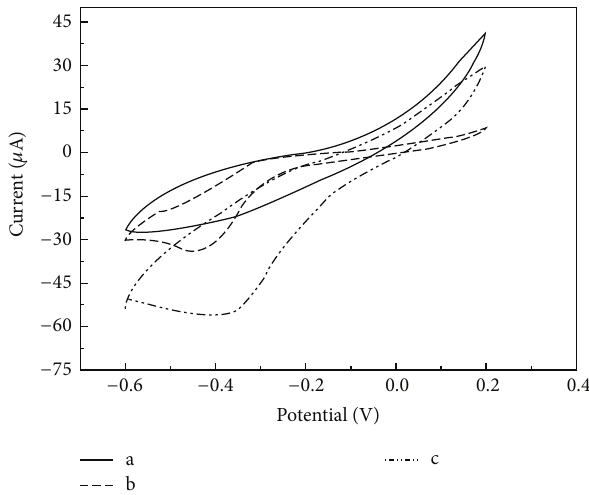
Figure 2: Cyclic voltammograms of MnO 2 for ORR at scan rate of 100 mV/s in 0.l M KOH. (a) Electrolyte bubbled with N 2 ; (b) NSM; (c) HSM. (b)-(c) Electrolyte bubbled with O 2